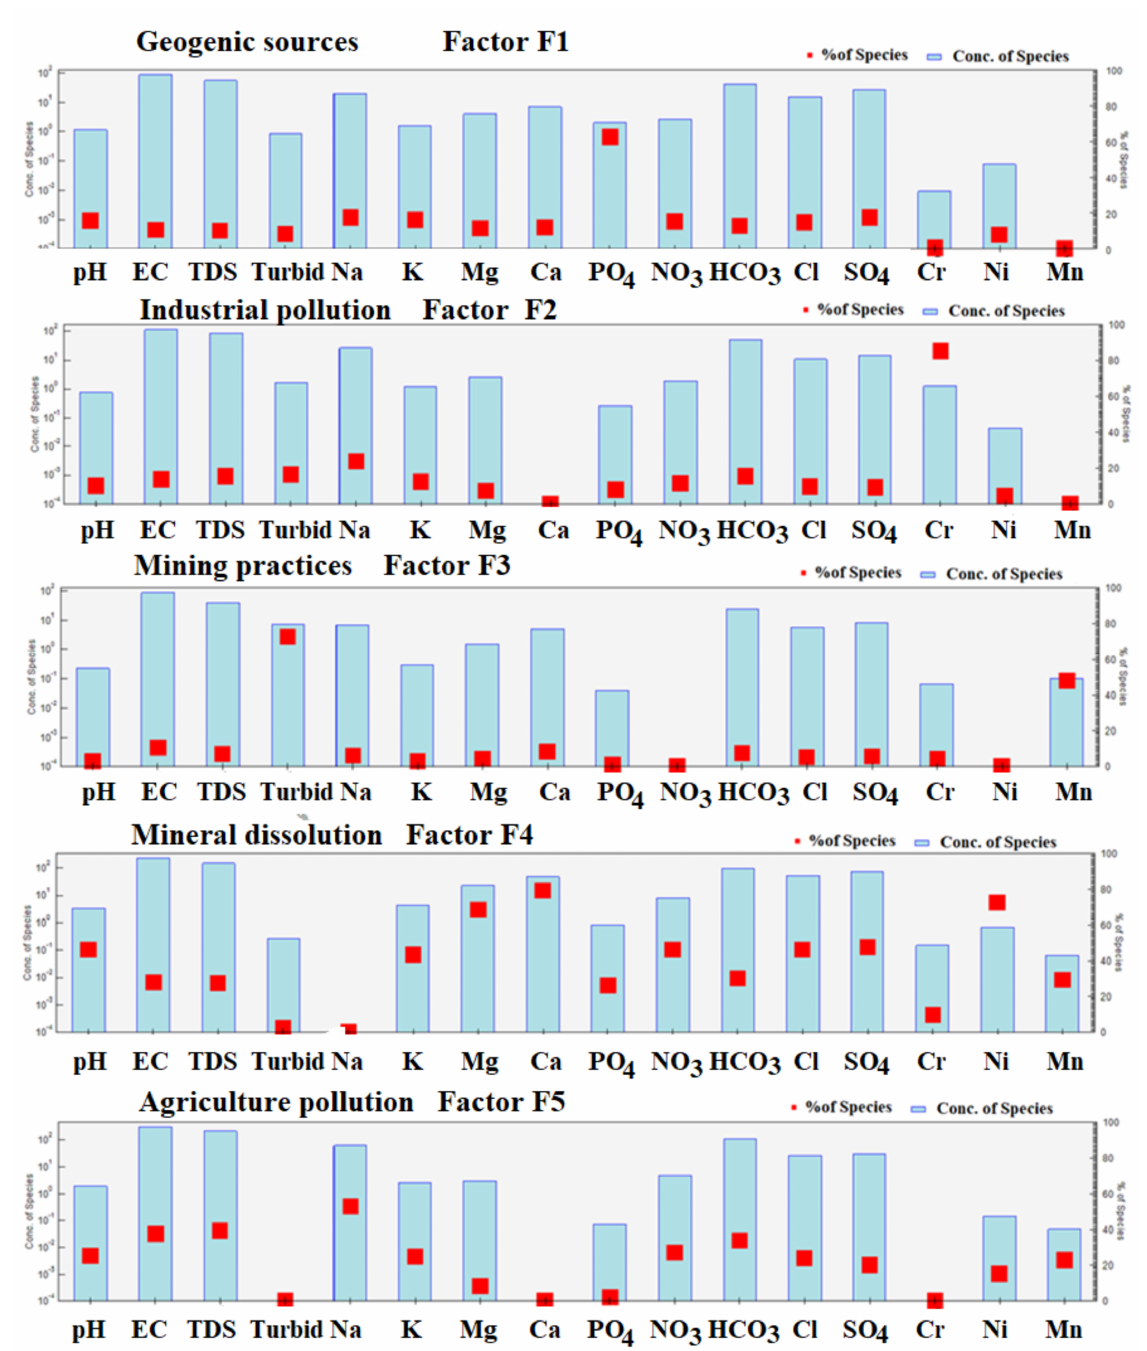
Figure 9. Factors determine the contribution of different processes controlling the groundwater chemistry using the PMF